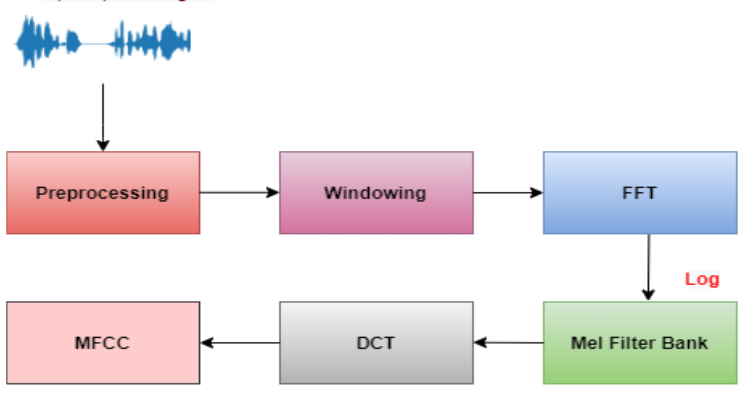
Figure 3. The MFCC production process.